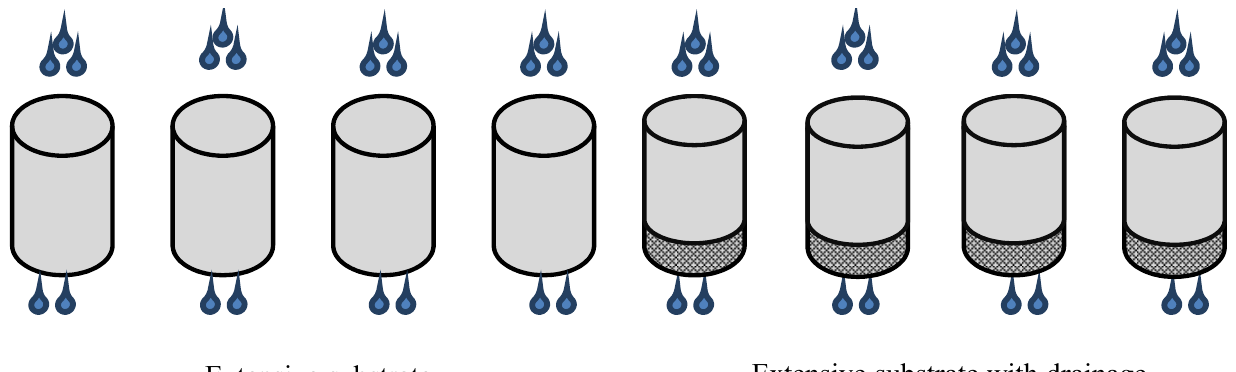
Figure 2. Set up of column experiment.